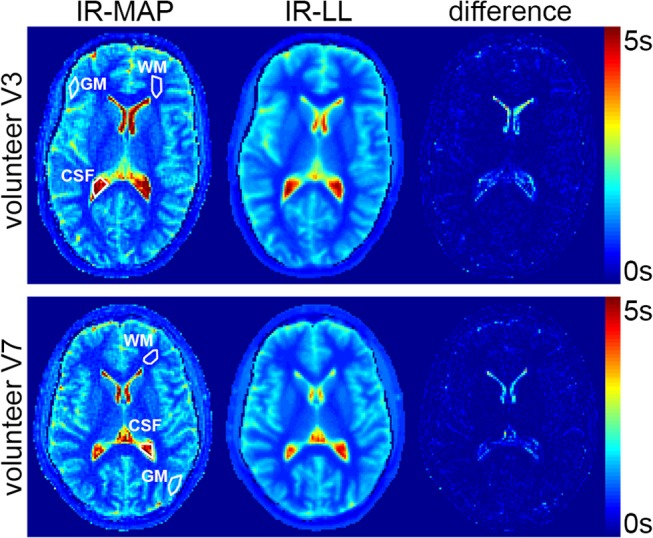
T1 maps of the IR-MAP reconstruction (left) and the segmented IR-LL reference (center) as well as a difference (right) for volunteers V3 and V7.